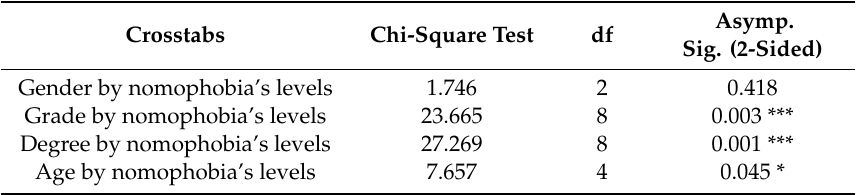
Figure 1. Burt table corresponding to the nested crossing of the variable levels of nomophobia by gender, by course, by degree and by age. Table 5. Results of the tables contingence.